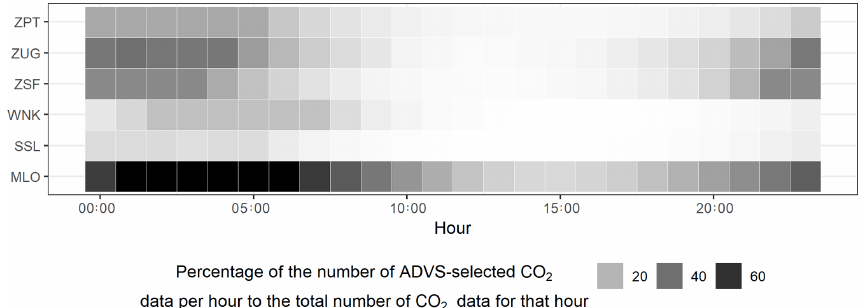
Figure 3. Frequency of the percentages of the number of ADVS-selected CO 2 data for each hour (0 to 23) in the total number of CO 2 data for that hour as shown in greyscale.